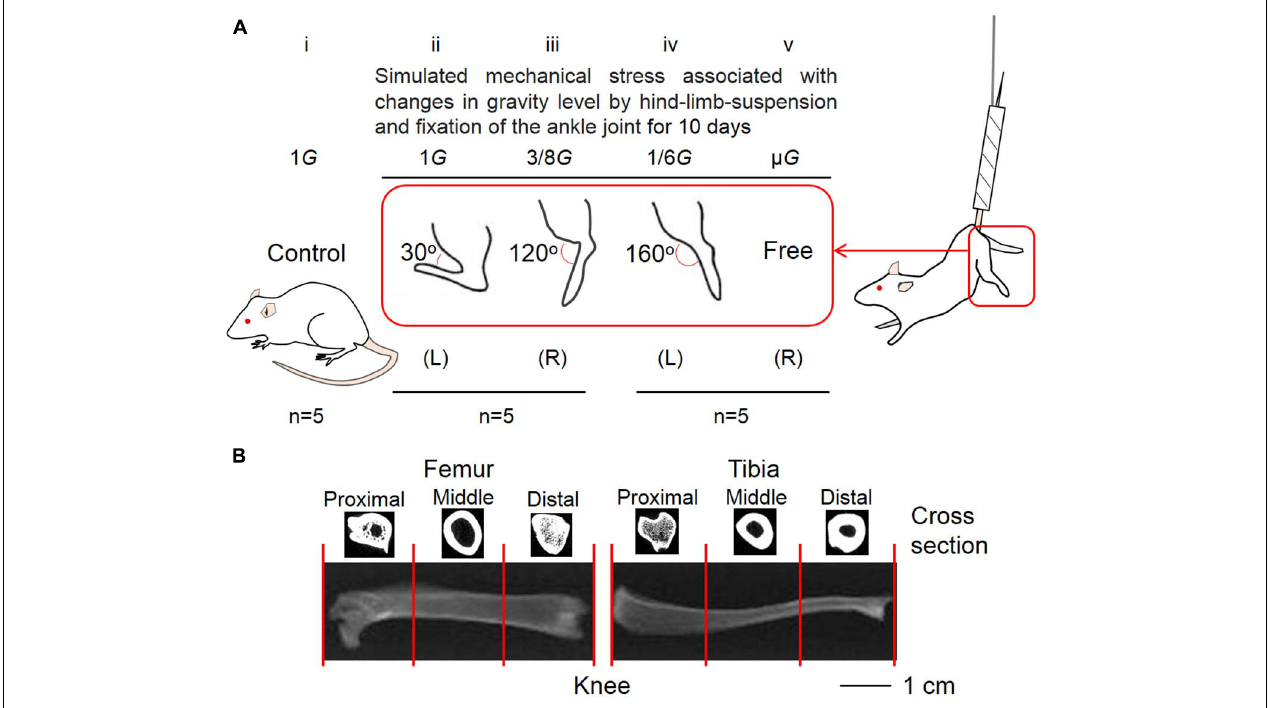
FIGURE 1 | Five experimental groups (A) and segmentation of lower limb bones (B) . The control (Ai) and suspension rat groups had their ankle joints fixed at 30 ◦ to simulate the effect of 1 G experienced on Earth (Aii) , 120 ◦ to simulate 3/8 G experienced on Mars (Aiii) , and 160 ◦ to simulate 1/6 G of the Moon (Aiv) . The ankle joints were not fixed to simulate the µ G of the outer space (Av) . (B) For analysis, the femur and tibia were divided into three equal parts, namely, proximal, middle, and distal positions.